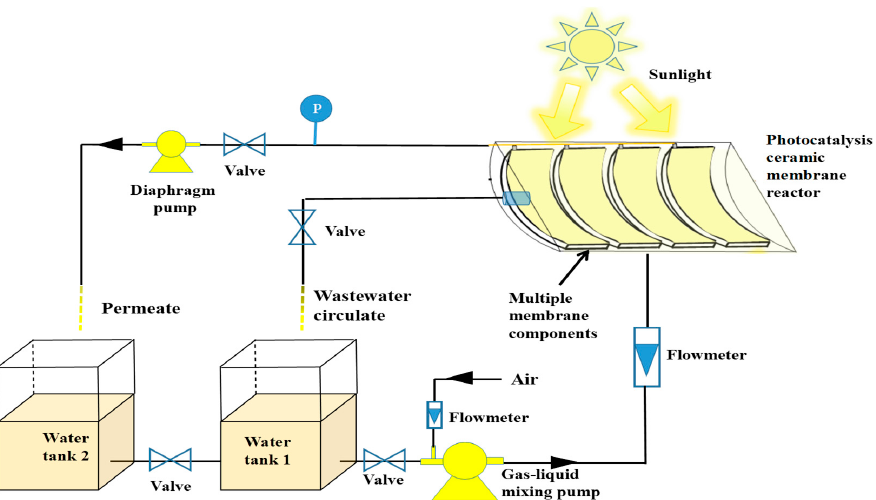
Figure 10. Proposed equipment diagram of photocatalytic ceramic membrane integrated pilot test.